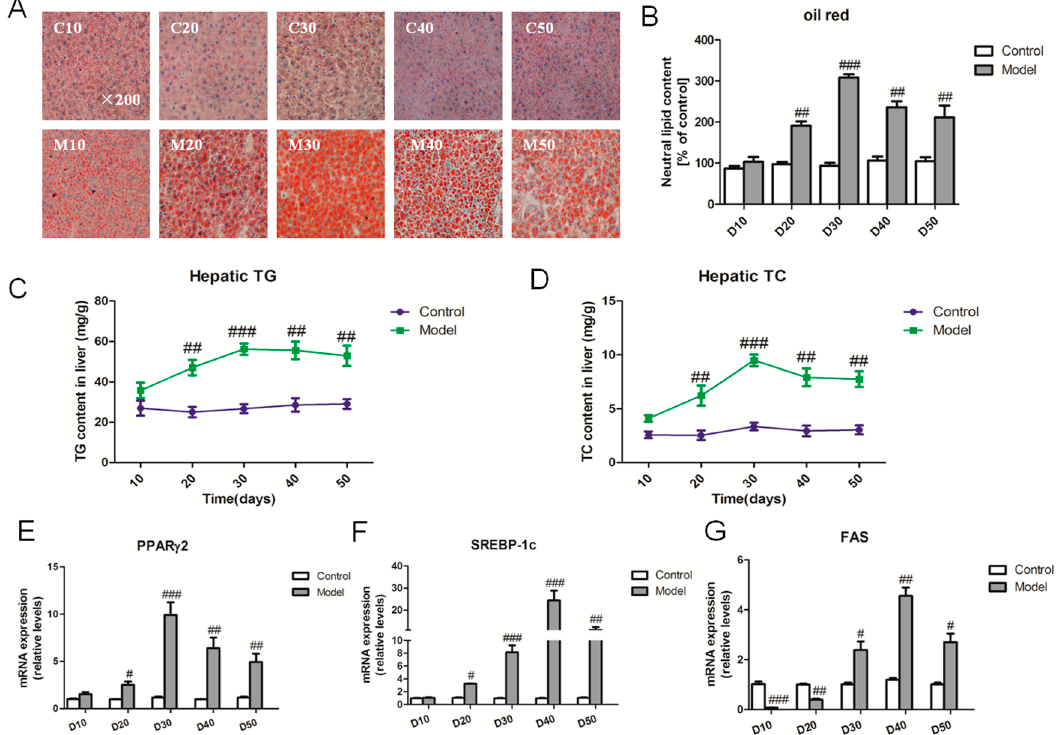
Figure 2. High fat-sucrose diet induced fat overload in liver. The hepatic lipid metabolism of SD rats induced by a high fat-sucrose diet on day 10, 20, 30, 40, 50. ( A ) Oil red O staining (small red circles) shows neutral lipid deposition in the liver (original magnification 200 × ). Small red circles indicate the formation of large cytoplasmic lipid droplets; ( B ) Semi-quantitative analysis of the contents of lipid droplets; ( C ) Hepatic TG content; ( D ) Hepatic TC content; the relative lipid synthesis gene PPAR γ 2 ( E ), SREBP-1c ( F ), FAS ( G ) mRNA expression. The values are shown as the means ± SEM ( n = 6). Compared with the corresponding control group, # p < 0.05, ## p < 0.01, ### p < 0.001.